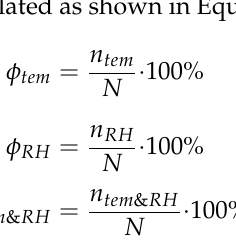
Figure 6. Schematic diagram of the HVAC system operation. Figure 7. Schematic diagram of the TRNSYS simulation system.